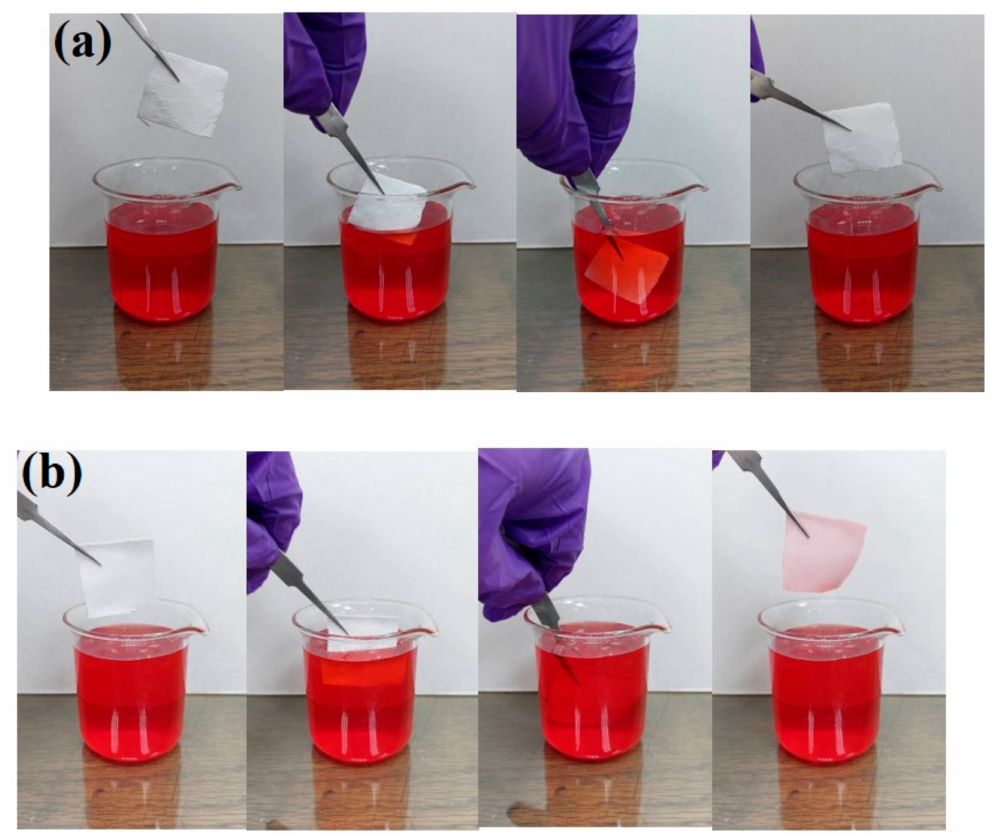
Figure 7. Antifouling tests of the ( a ) EPS@textile and ( b ) bare textile against